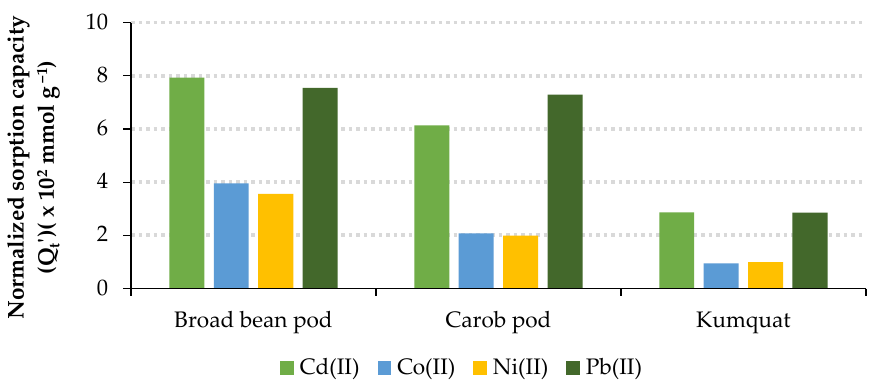
Figure 1. Normalized sorption capacity Q t ’ (mmol g − 1 ) of metal ions for biomasses with high and positive correlation: Group I.